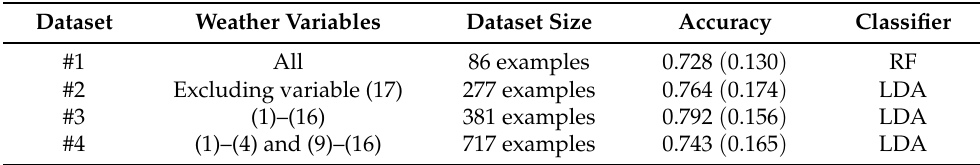
Table 6. Summary of results for HV